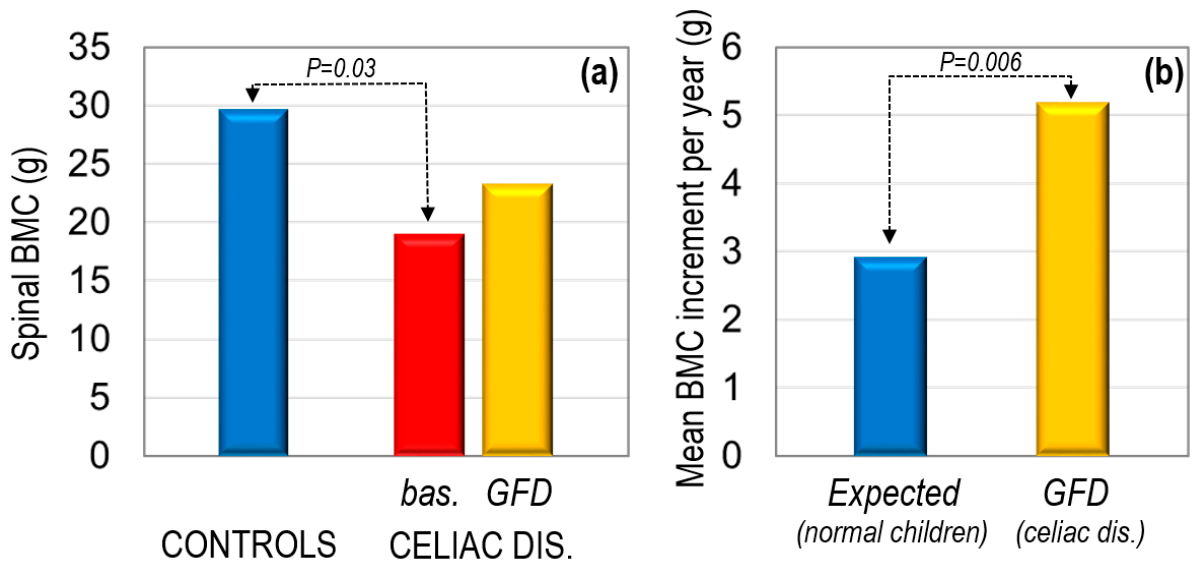
Figure 2. Effects of a gluten-free diet (GFD) on the spinal bone mineral content (BMC) ( a ) as assessed by the dual X-ray absorptiometry (DXA) technique and annual BMC increment and ( b ) in children with celiac disease ( n = 22) as compared with 428 healthy, age-matched controls (derived from Barera G et al. [81,82]). Bas: baseline.